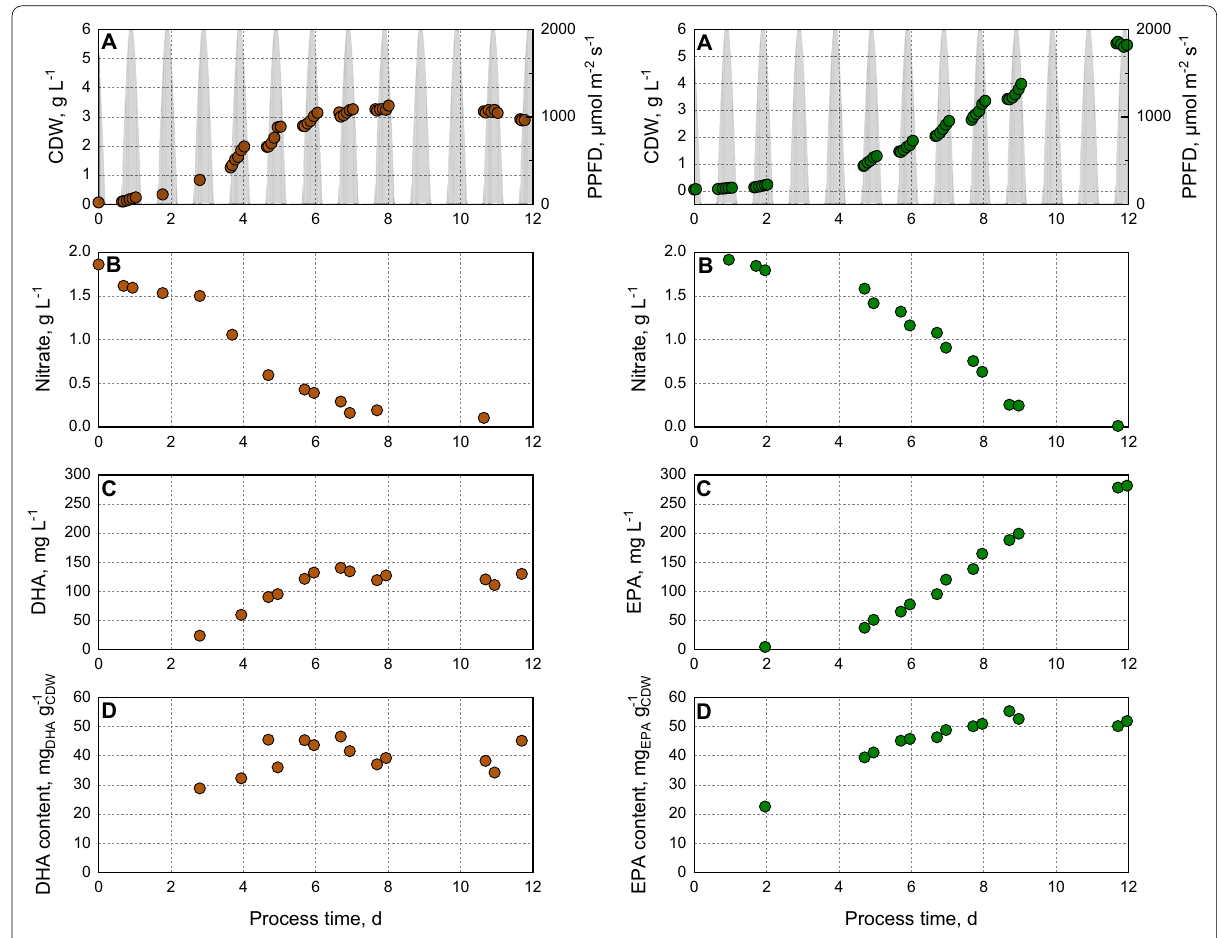
Fig. 3 Phototrophic batch processes with T. lutea (right, red circle) and M. salina (left, green circle) in flat‑plate gas‑lift photobioreactors under simulated climate conditions. A Cell dry weight concentration, B nitrate concentration, C DHA (red circle) or EPA (green circle) concentration, and D DHA (red circle) or EPA (green circle) content of total cell dry weight. The batch processes were operated at a working volume of 1.8 L, pH 8.0 and an initial nitrate supply of 1.8 g L − 1 . Monocultures were inoculated at an OD 750 of